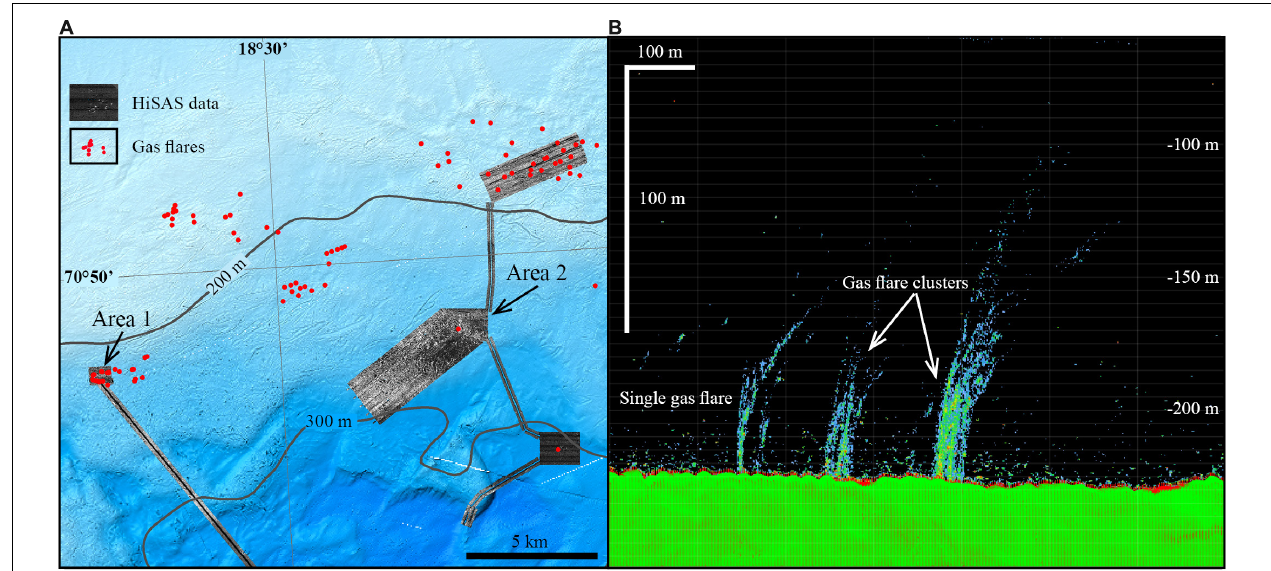
FIGURE 3 | (A) Gas flares and synthetic aperture sonar data. (B) Side view of multibeam echosounder line showing a single gas flare and two gas flare clusters. The gas flare clusters correspond to the two carbonate crust fields shown in Figure 5